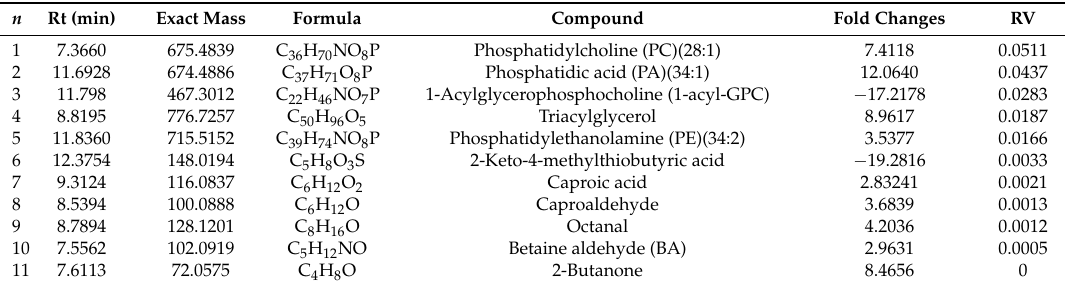
Table 2. Identified differential metabolites in the interstitial lung abnormalities (ILAs) group.